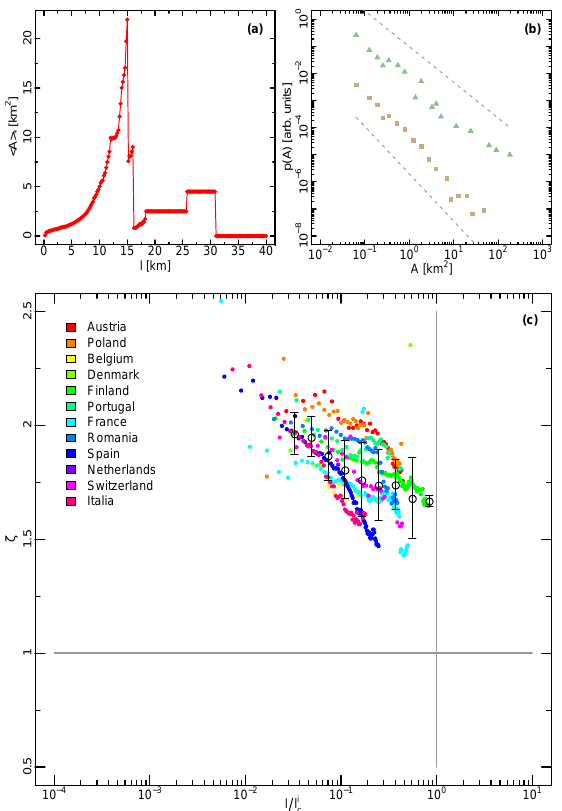
Figure 4. Percolation and Zipf’s law. ( a ) Average cluster size excluding the largest component (cid:104) A (cid:105) ∗ as a function of the clustering parameter l for Austria. The maximum is located at the percolation transition, which in this example is l c (cid:39) 15km; ( b ) Probability density of cluster areas p ( A ) for Austria and for l c (370 clusters, green triangles) as well as l (cid:39) 2 l c (87 clusters, brown squares). The dotted grey l (cid:39) 1 3 3 lines have the slopes − 1.71 and − 1.27; ( c ) Estimated power-law distribution exponent ζ A as a function of the rescaled clustering parameter l / l c for various countries as indicated by colored dots. Since we found out that the method proposed in [28] has a significant deviation from the real value for input with less than 100 entries, we estimated the power-law distribution exponents for each country just for those l with at least 100 clusters remaining. The open circles represent averages in logarithmic bins and their error bars the corresponding standard deviations. The exponent decreases with increasing l / l c and takes values between ζ A ≈ 2 for l / l c (cid:28) 1 and ζ A ≈ 3/2 for l / l c →